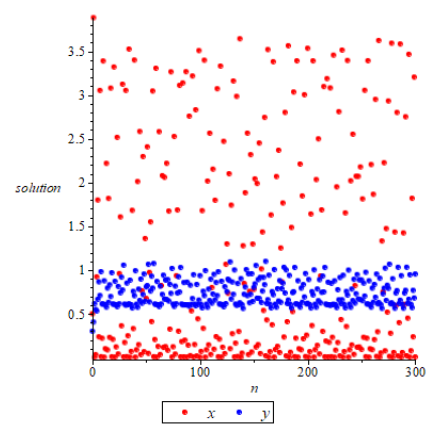
Figure 4. The positive equilibrium is